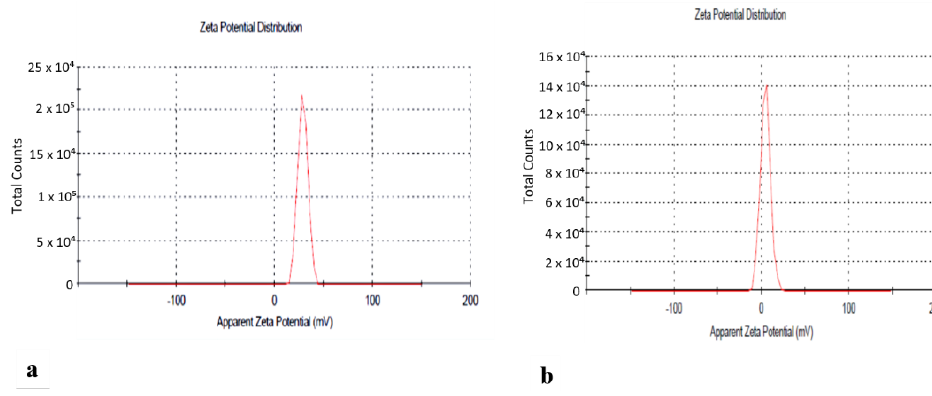
Figure 6. ( a ) Zeta potential of cs-TPP NPs. ( b ) Zeta potential of n -hexane cs-NPs.